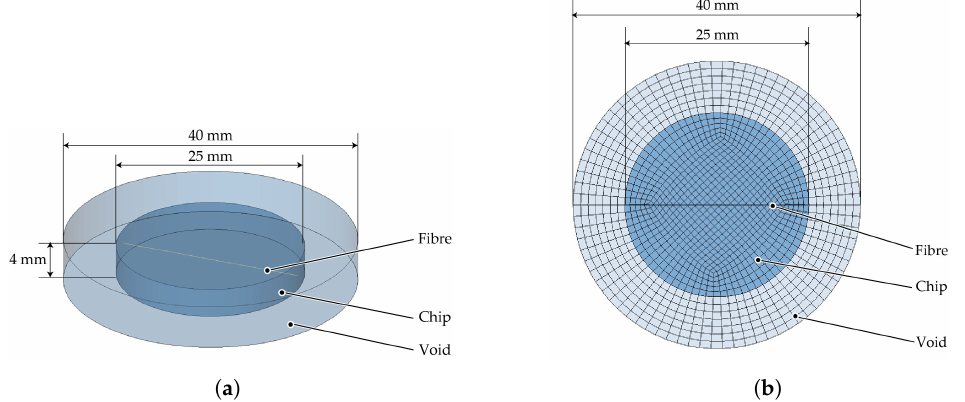
Figure 10. Numerical setup for the rheologicalFSI model with the ALE method. ( a ) Geometric structure of ALE model. ( b ) Mesh division of ALE model.